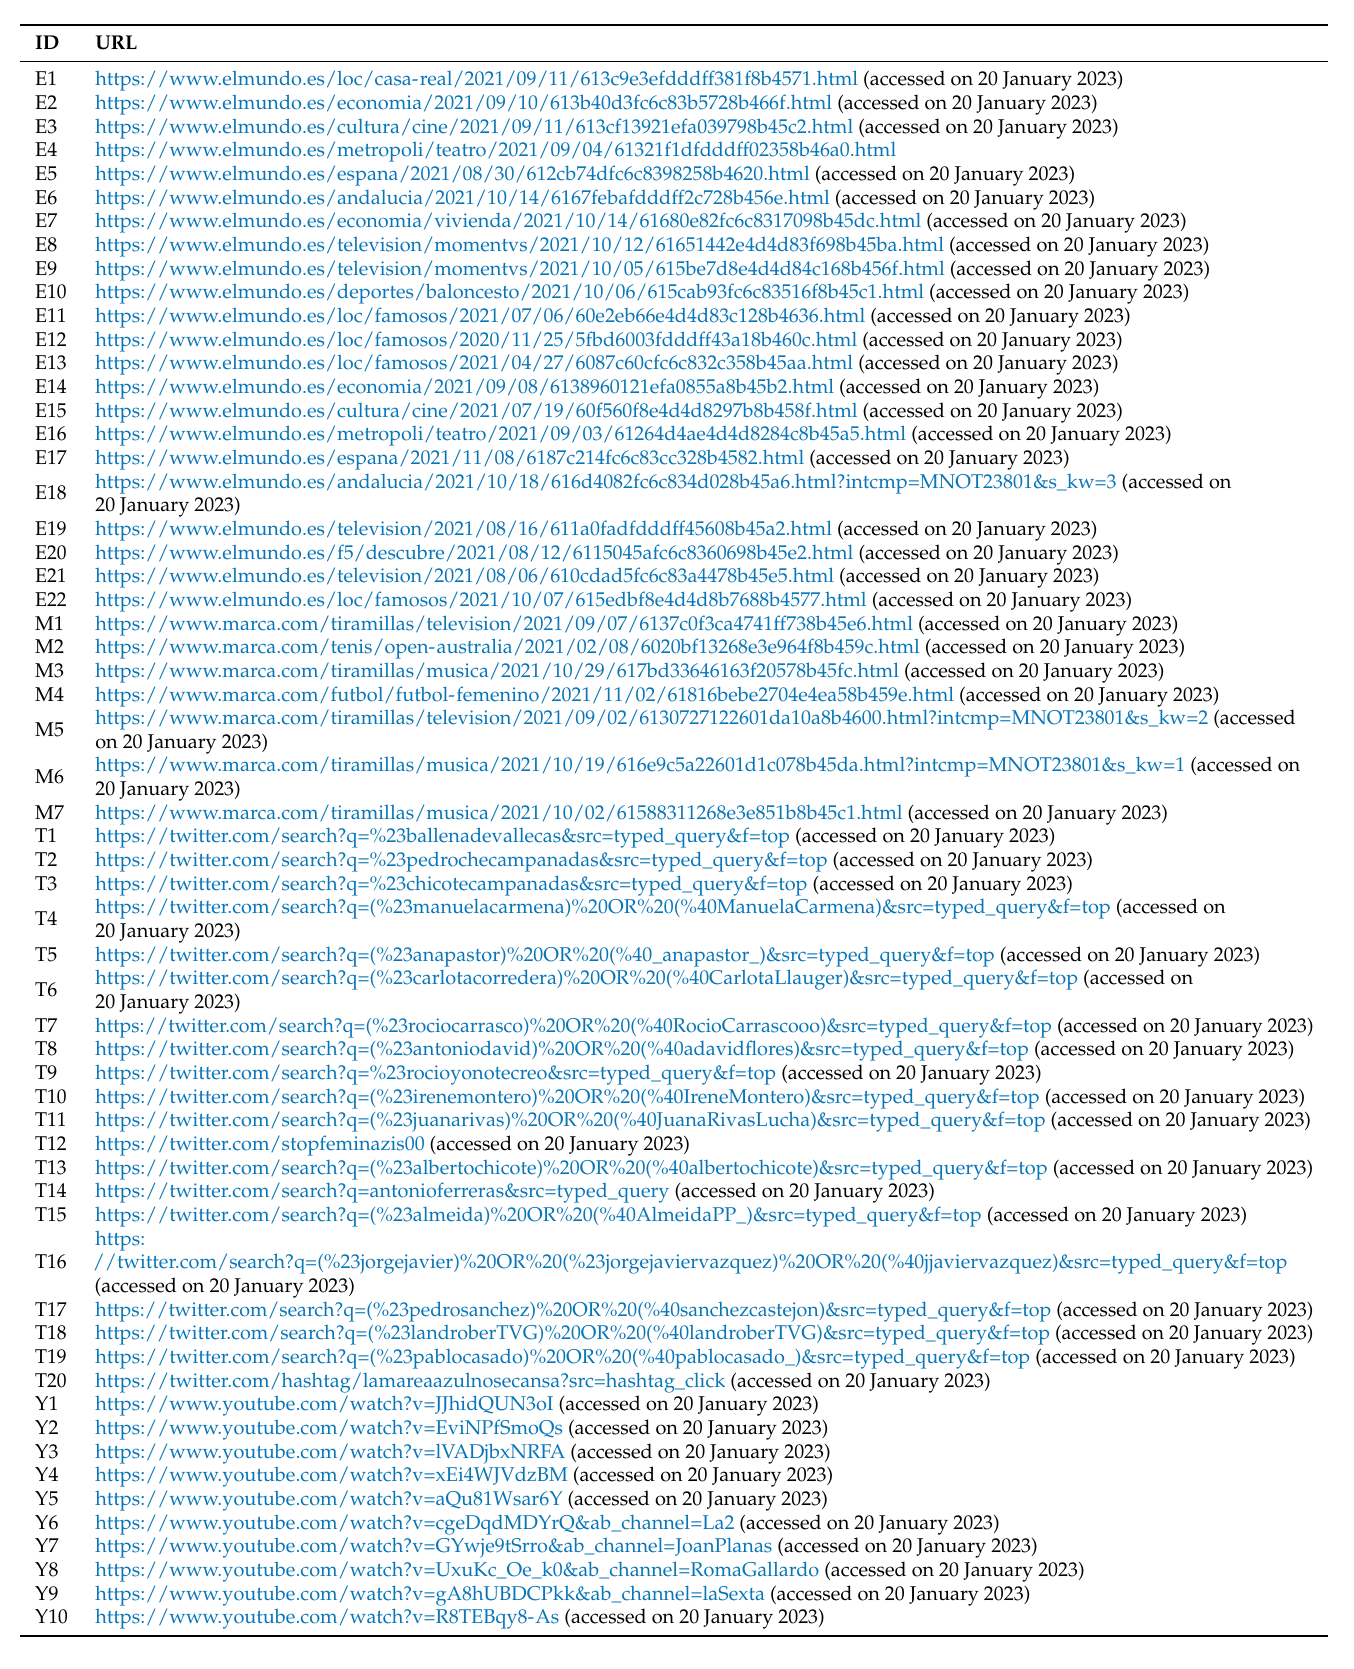
Table A1. List of content sources used to create the data